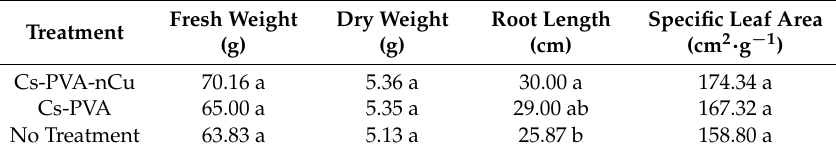
Table 4. Effect of Cs hydrogel treatments on watermelon biomass